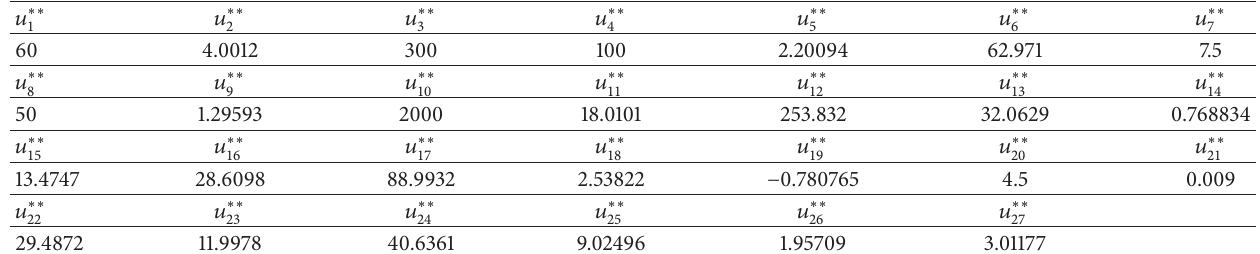
Table 3: Optimal dynamical parameter